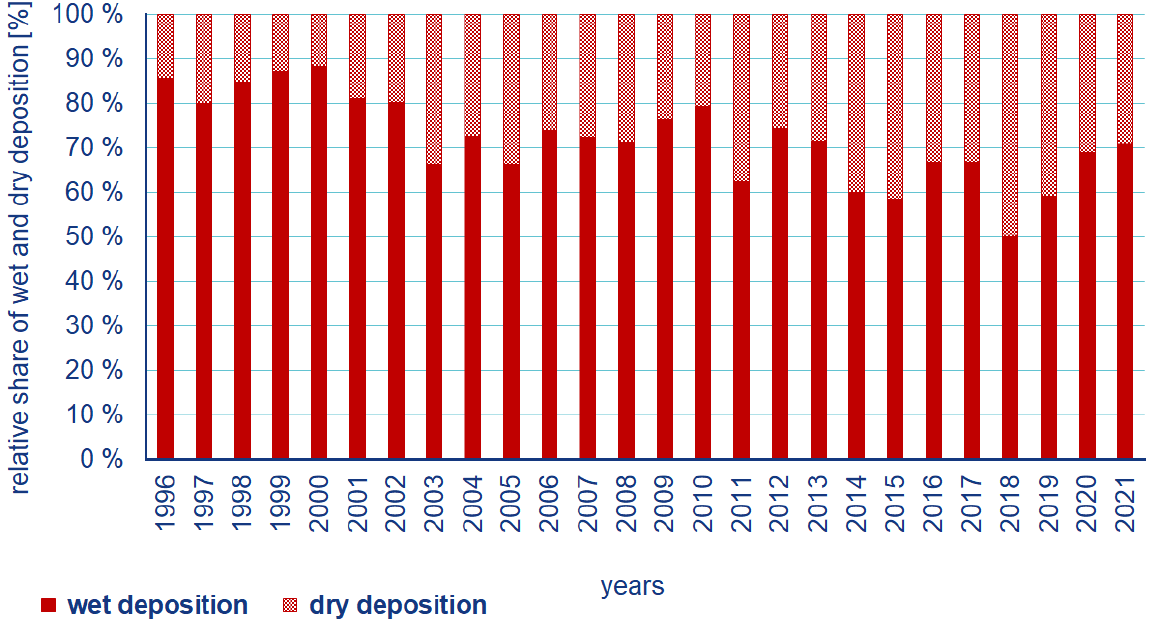
Figure 8. Relative contributions of wet and dry deposition of Cd over the entire area of the Czech Republic (78,841 km 2 ) based on data-driven geostatistic model, 1996–2021.